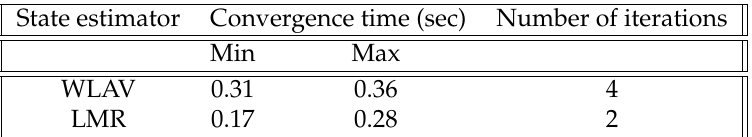
Table 5. IEEE 30 Bus - Computation efficiency of the state